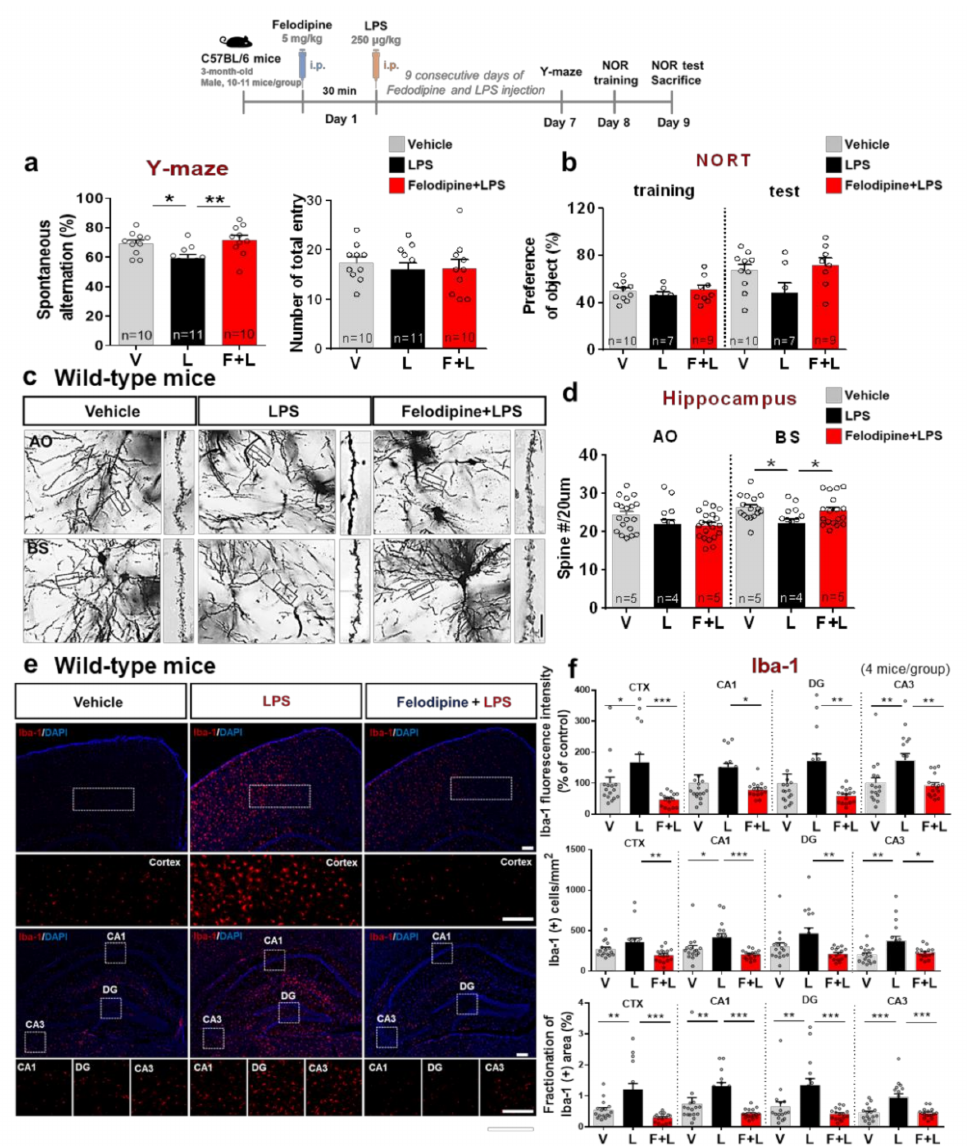
Figure 8. Treatment with felodipine daily for 9 days modulates LPS-induced short-term working memory impairment, hippocampal dendritic spine loss, and microgliosis in C57BL/6 mice. Three- month-old C57BL/6 mice were injected daily with vehicle (5% Tween-20 + 5% PEG300 in saline) or felodipine (5 mg/kg, i.p.), followed 30 min later by 250 µ g/kg LPS or PBS for 9 days. ( a ) Y-maze tests were performed on day 7; spontaneous alternations and the number of total entries are shown (vehicle, n = 10 mice; LPS, n = 11 mice; felodipine+LPS, n = 10 mice). ( b ) Novel object recognition (NOR) training/tests were performed on days 8 and 9; object preference is shown (vehicle, n = 10 mice; LPS, n = 7 mice; felodipine+LPS, n = 9 mice). ( c ) Golgi staining was performed after the behavior experiments to measure dendritic spine number in the hippocampal AO and BS dendrites. ( d ) Quantification of data from ( c ) (vehicle, n = 19 slices from 5 mice; LPS, n = 15 slices from 4 mice; felodipine+LPS, n = 20 slices from 5 mice. ( e ) Microgliosis was assessed via immunofluorescence staining of Iba-1 in brain slices from the C57BL/6 mice used in the behavioral experiments. ( f ) Quantification of data from ( e ) (n = 4 mice/group, n = 16 brain slices). * p < 0.05, ** p < 0.01, *** p < 0.001. Golgi staining scale bar = 5 µ M. IF scale bar = 100 µ M. V: vehicle; L: LPS; F or Felodi: